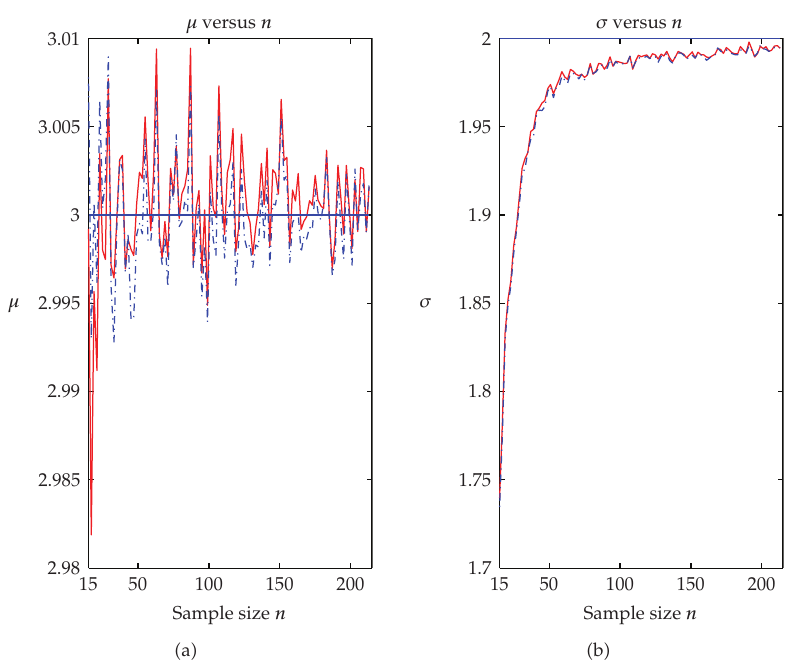
Figure 5: Grouped data: τ 1 (cid:8) − 2, τ 2 (cid:8) 0, τ 3 (cid:8) 2, τ 4 (cid:8) 4, τ 5 (cid:8) 6. Type I left censored data: τ (cid:8) − 2